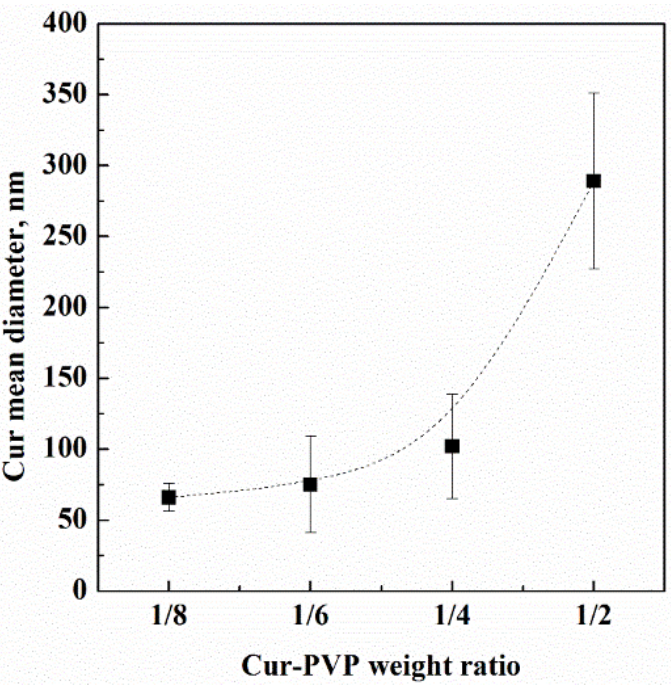
Figure 8. Curcumin mean diameter evolution (highlighted by the dashed line) in PVP microparticles, depending on the Cur-PVP weight ratio.